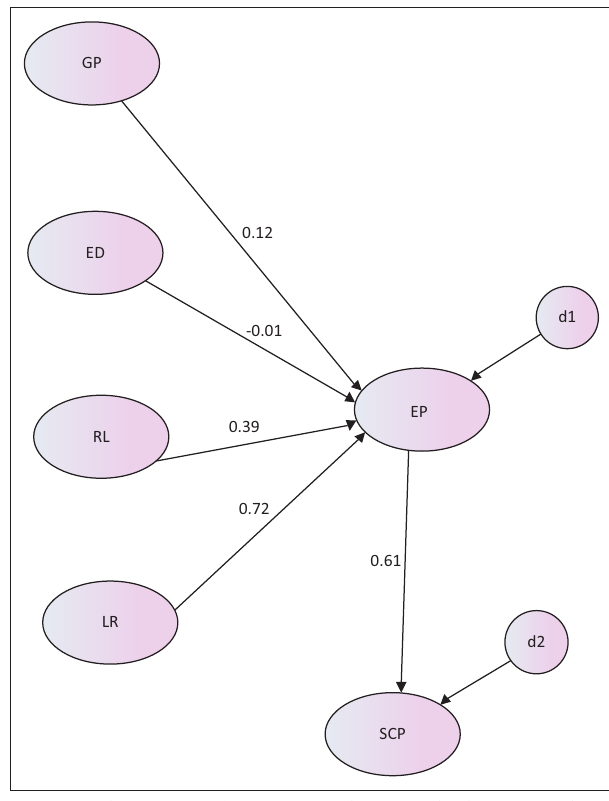
FIGURE 2: Structural model for green supply chain management practices, environmental performance and supply chain